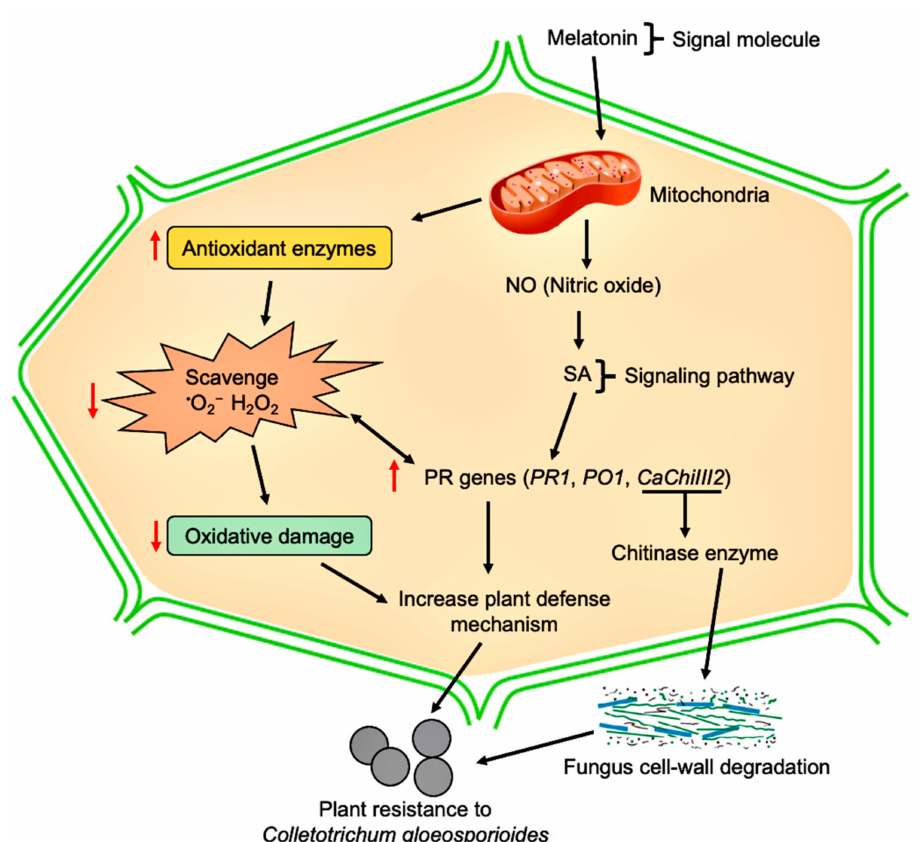
Figure 10. A proposed model for the mechanism of chitinase gene CaChiIII2 in melatonin-mediated innate immunity against C. gloeosporioides